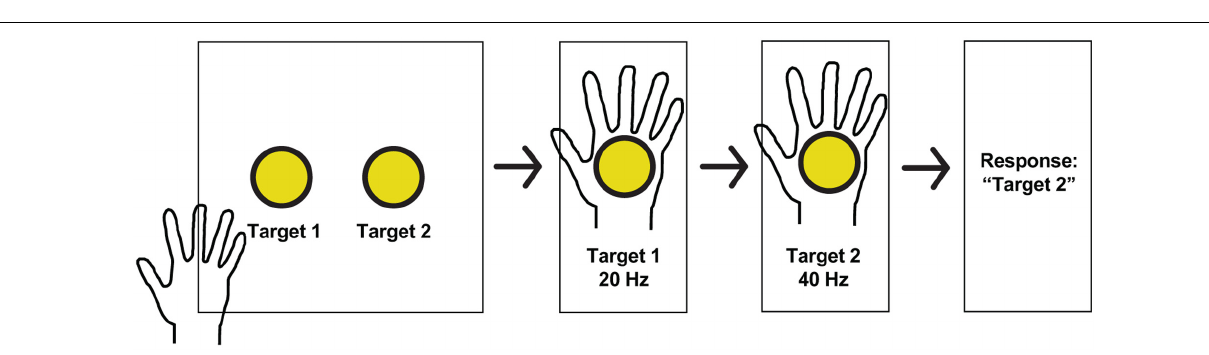
FIGURE 2 | Experimental paradigm and hand receptive fields. Schematic of a typical session. Subjects received stimulation at one of two pseudorandomly determined frequencies when searching for targets in a 2-dimensional space, and reported which target had the higher frequency, whether or not they guessed, and whether or not both stimulations were